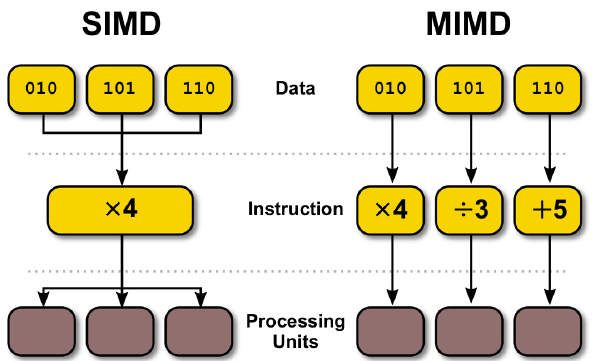
Figure 1. MIMD is versatile, allowing multiple heterogeneous instructions to be carried out on a pool of data. SIMD is simple and performs the same operation on a pool of data. Instructions are not limited to arithmetics and can take different forms (logical, transfer,